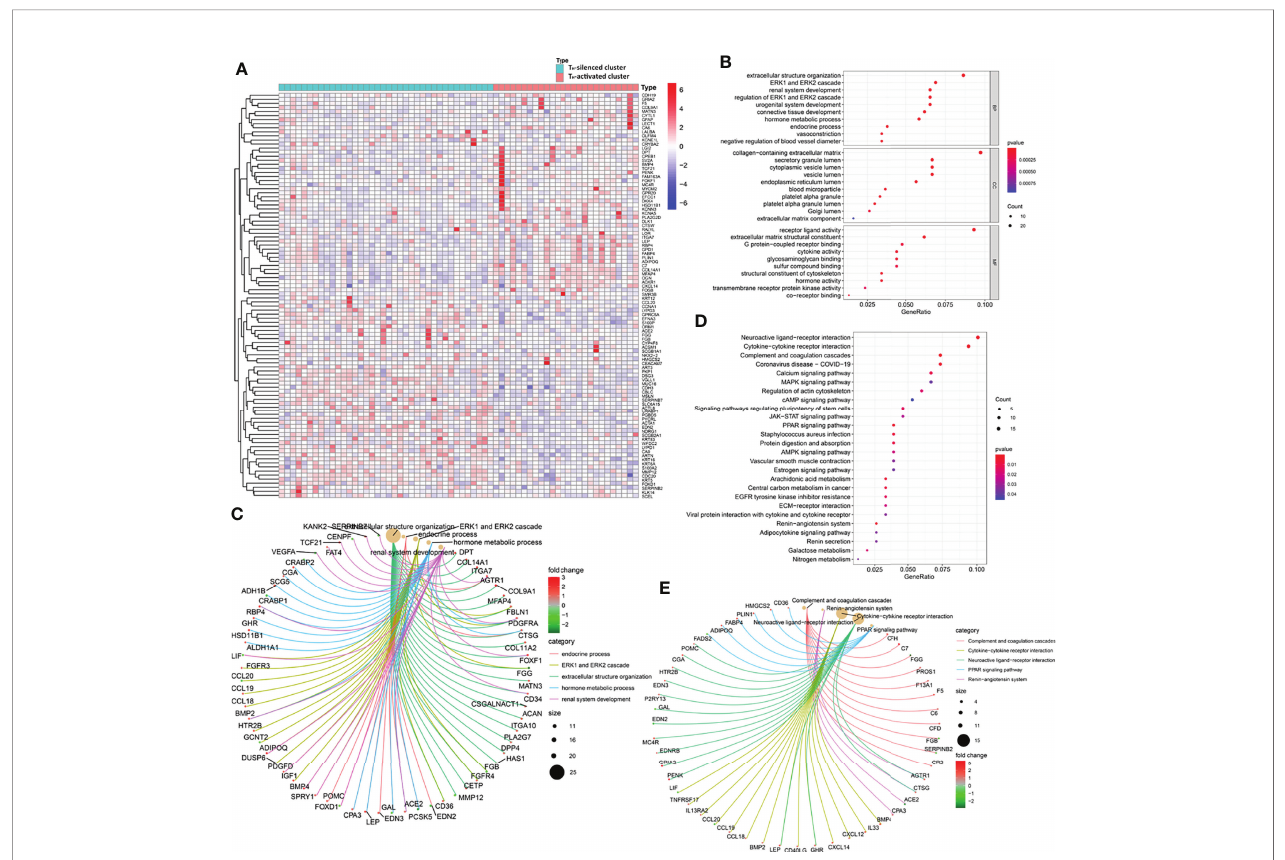
FIGURE 3 | The gene pro fi le characteristics of two clusters identi fi ed by T H cells from GSE31519 TNBC samples cued the correlation between T H cells and ECM in the TIME. (A) Heatmap of the differential expression of the 100 prominent DEGs between the two clusters from the GSE31519 dataset (logFC fi lter=1 and fdrFilter=0.05). The bubble diagram (B) and circle diagram (C) showed that ECM-related pathways were enriched from GO enrichment analysis of the DEGs. The bubble diagram (D) and circle diagram (E) showed that cytokine – cytokine receptor interaction, JAK-STAT signaling pathway, and ECM – receptor interaction were enriched from KEGG enrichment analysis of the